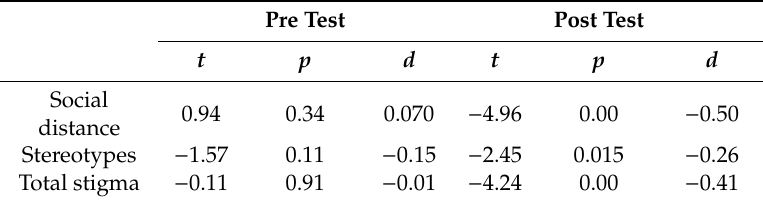
Table 1. Pre-test and post-test di ff erences between the experimental group and the control group. Pre Test Post Test t p d t p d Social 0.94 distance